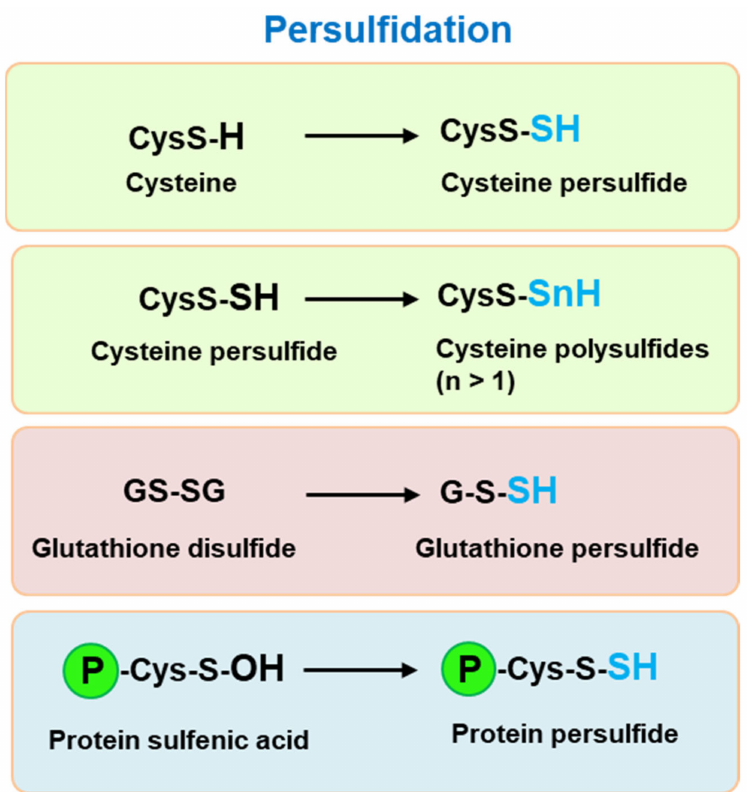
Figure 2. Examples of persulfidation of low and high molecular weight thiol compounds including cysteine (Cys), glutathione disulfide (GSSG) and protein undergoing Cys modifications